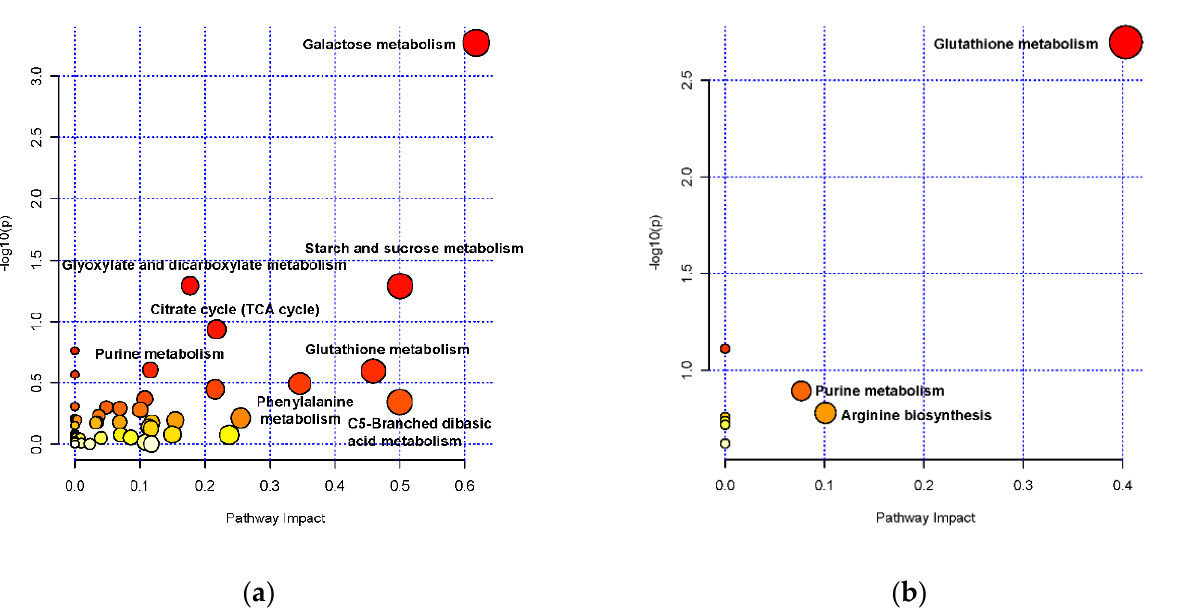
Figure 5. ( a ) KEGG pathway impact analysis showing altered metabolism in NJF vs. NJS group. ( b ) KEGG pathway impact analysis showing altered metabolism in JZF vs. JZS. The X-axis indicates pathway impact, and the Y-axis indicates enrichment. The dots with larger size and darker color represent the main pathway enrichment and higher pathway impact values, individually.